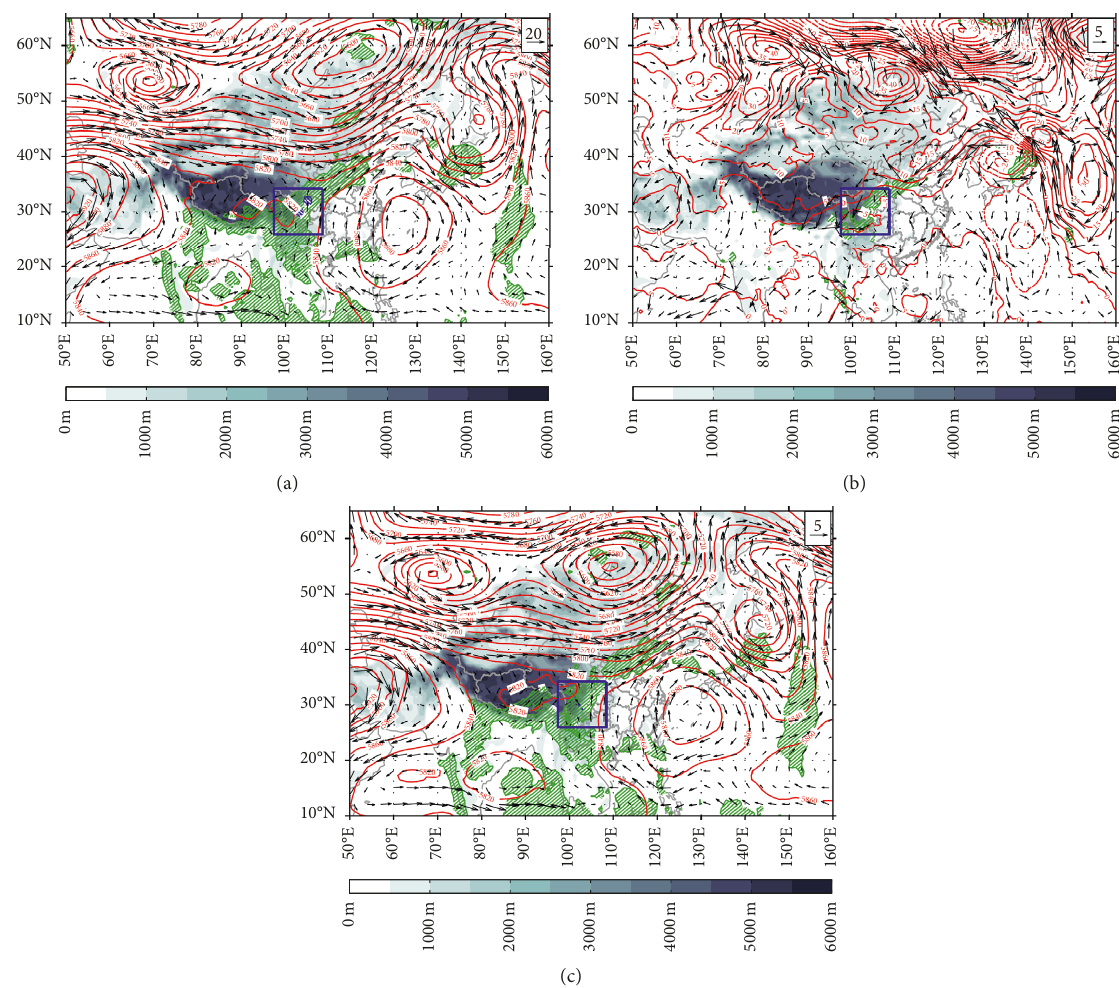
Figure 5: The 500hPa GPHs (red contours; unit: gpm) and wind (black vectors; unit: m/s) from ERA-Interim reanalysis data and gauge- based precipitation data (green contours for 10mm and blue contours for 50mm) in forecast for next 90–108h (4-time average, 1800 UTC 17 July–1200 UTC 18 July) after the initial time of 0000 UTC 14 July 2013. (a) Composite of six stronger members with the lowest values of TPMVI. (b) Composite of six members with the highest values of TPMVI. (c) Difference by six stronger members minus six weaker members. The blue rectangle indicates the Sichuan Province. The shaded areas show the terrain elevations (shaded every 1000m) in eastern